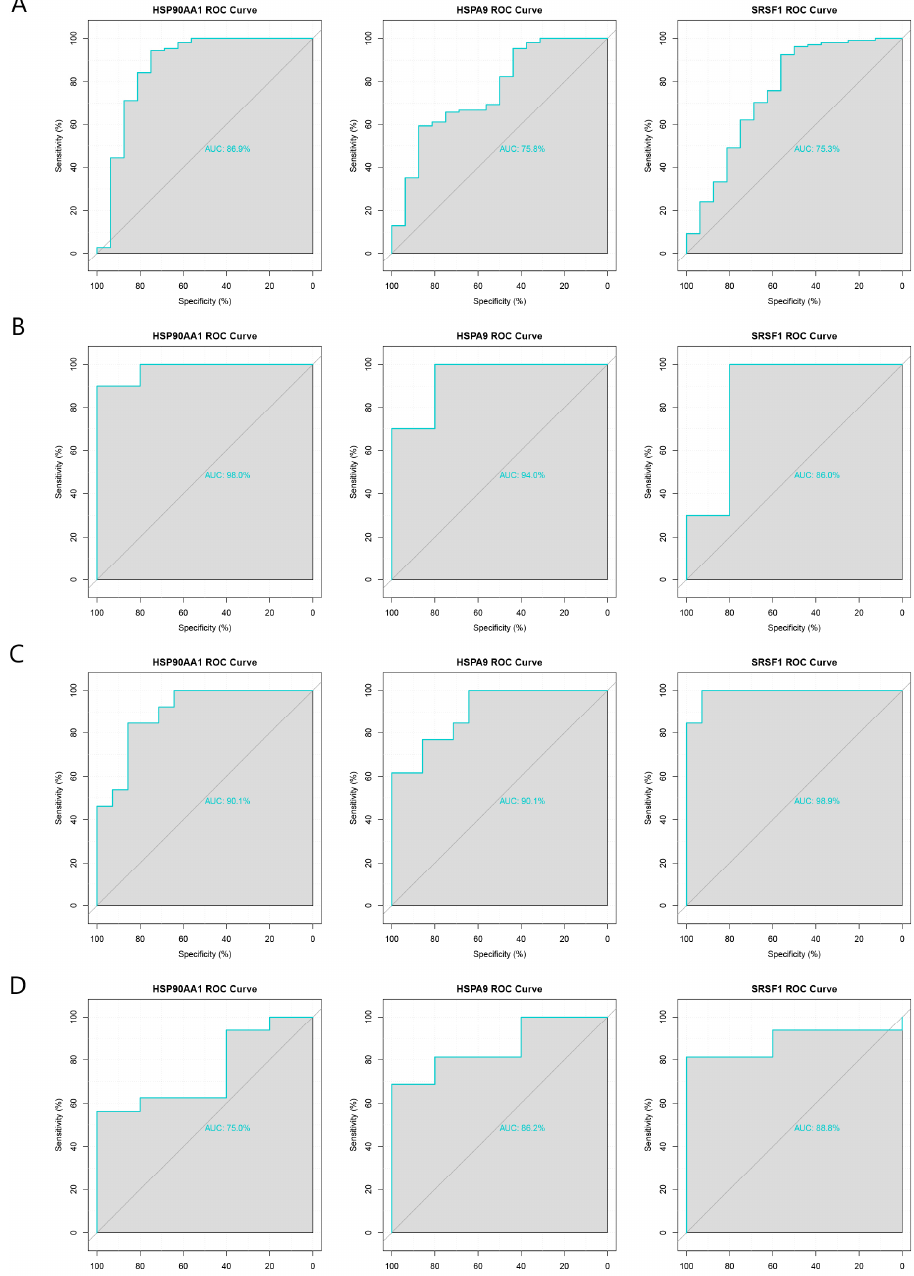
Figure 5. Validation of the diagnostic performance of the three pivotal genes using internal and external datasets. ( A ) ROC curves of the pivotal genes in the GSE5406 dataset (internal). ( B ) ROC curves of the pivotal genes in the GSE164805 dataset (internal). ( C ) ROC curves of the pivotal genes in the GSE116250 dataset (external). ( D ) ROC curves of the pivotal genes in the GSE211979 dataset (external).